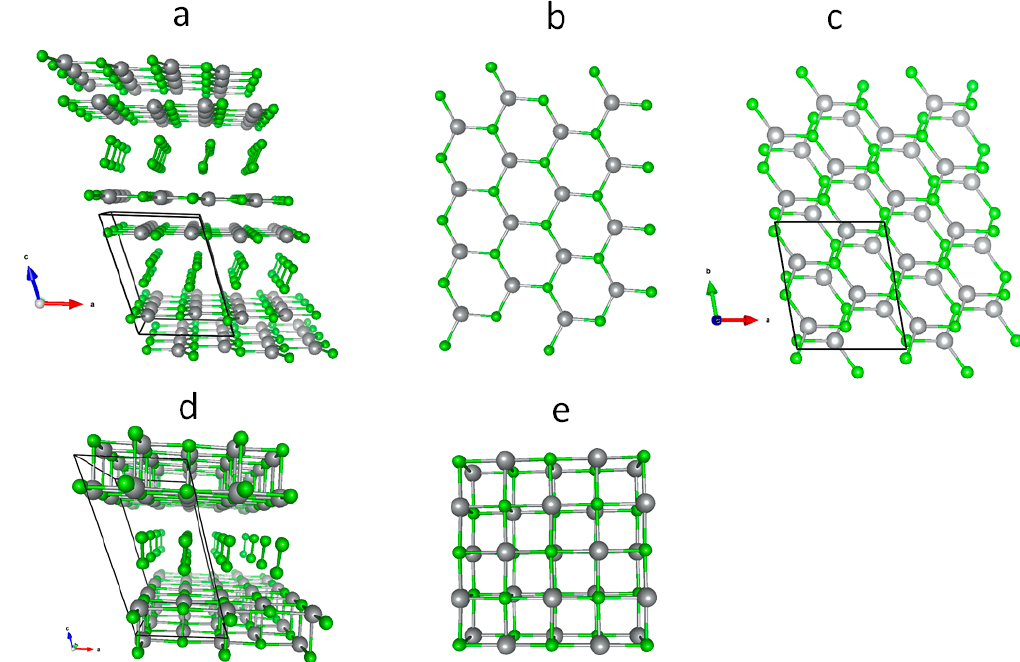
Figure 7. The predicted Ag(I)[Cl(Cl 2 ) ½ ] polymorphs: the crystal structure with hexagonal AgCl 2 double layers highlighting the unit cell, one AgCl layer and stacking of the AgCl layers, respectively ( a – c ), and an alternative structure with rock-salt AgCl double layers ( d , e ). 3. 3 . Relative and Absolute Energetic and Thermodynamic Stability of Several Important Polymorphic Forms of AgCl 2